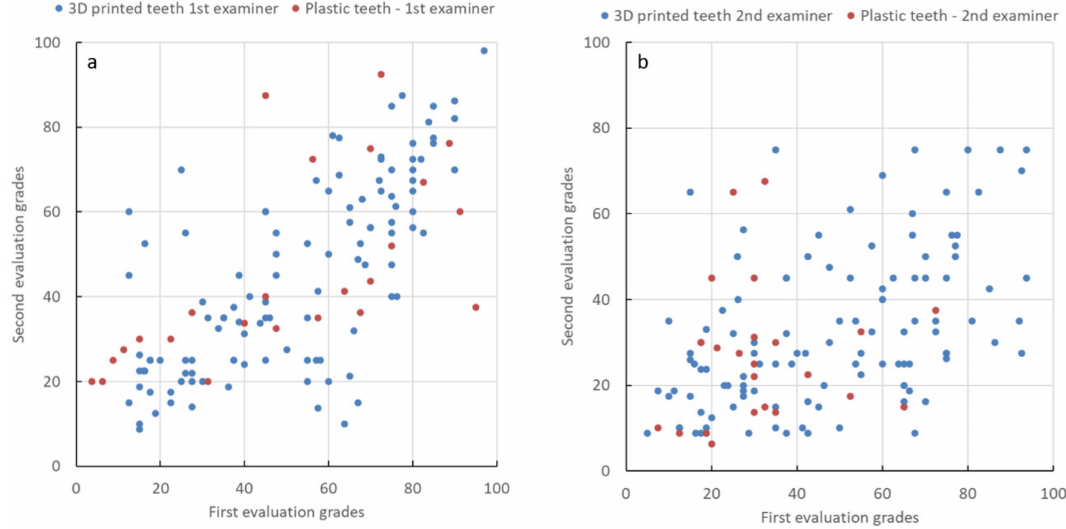
Figure 2. First vs. second preparation evaluation grades: ( a ) first examiner; ( b ) second